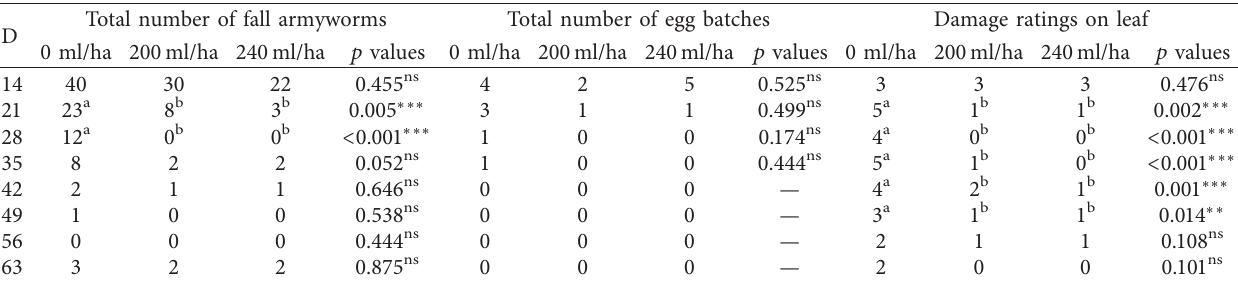
Table 2: Total numbers of fall armyworms and egg batches and damage ratings of maize leaf treated with Ampligo at rates of 0 ml/ha, 200ml/ha, and 240ml/ha.